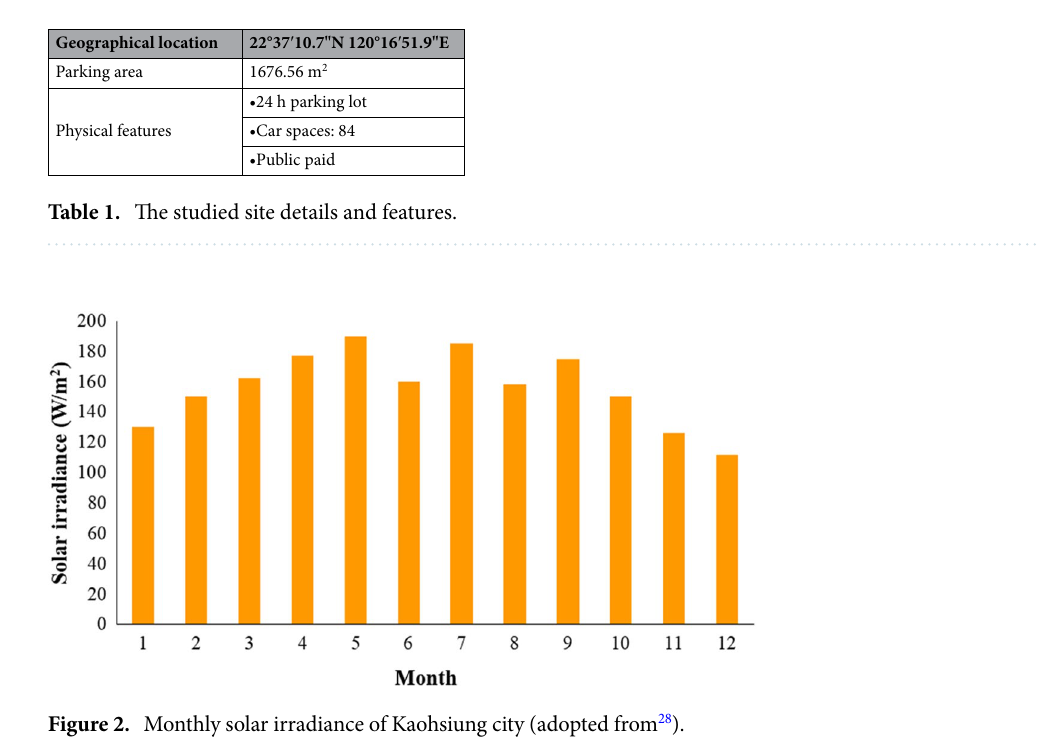
Figure 2. Monthly solar irradiance of Kaohsiung city (adopted from 28 ).